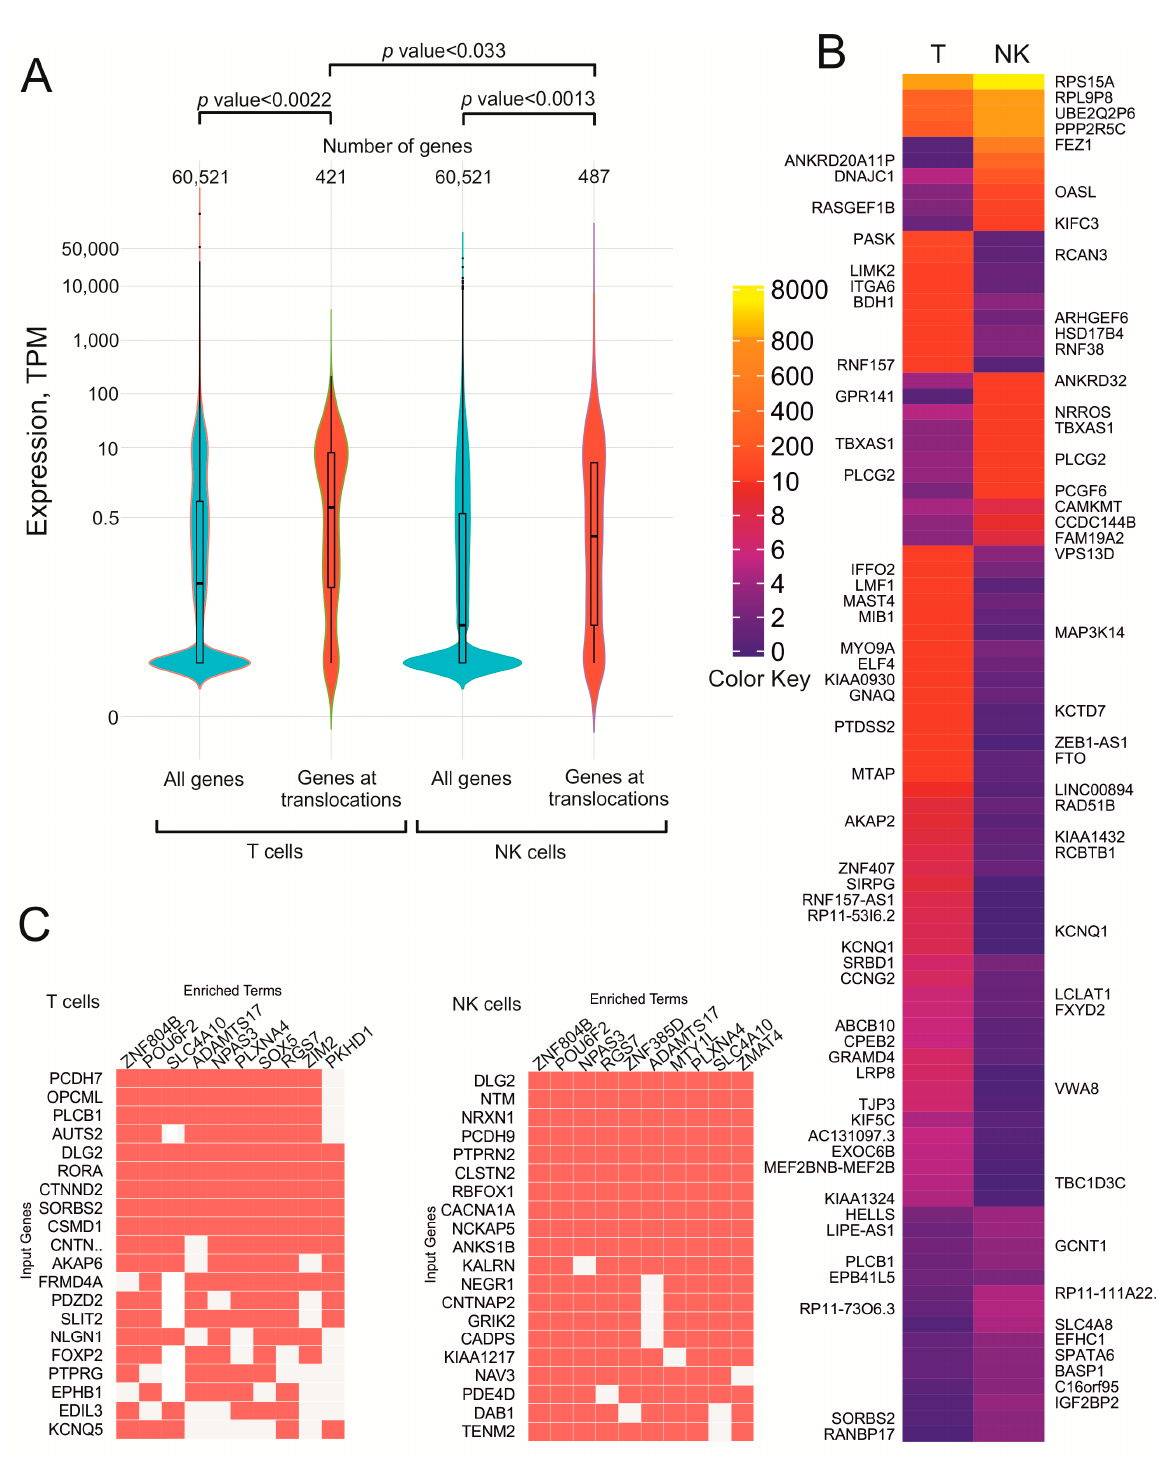
Figure 4. Expression of genes at translocation sites in normal T cells and in NK cells. ( A ) Violin plots showing the distribution of all genes along their expression levels (blue) and along genes at translocation sites in both cell types (red). The numbers of corresponding genes are shown at the top. ( B ) heatmap of 88 selected differentially expressed genes at translocation sites in T cells and NK cells. Gene names at translocation sites in T cells are indicated to the left and in NK cells to the right of the heatmap. The complete heatmap is shown in Figure S4. The values of the color key correspond to TPM. ( C ) the search of the genes at translocation sites was performed using the Enrichr Submissions TF-Gene Coocurrence resource. Input genes are the genes at translocation sites. Enriched terms indicate the transcription factors that jointly regulate